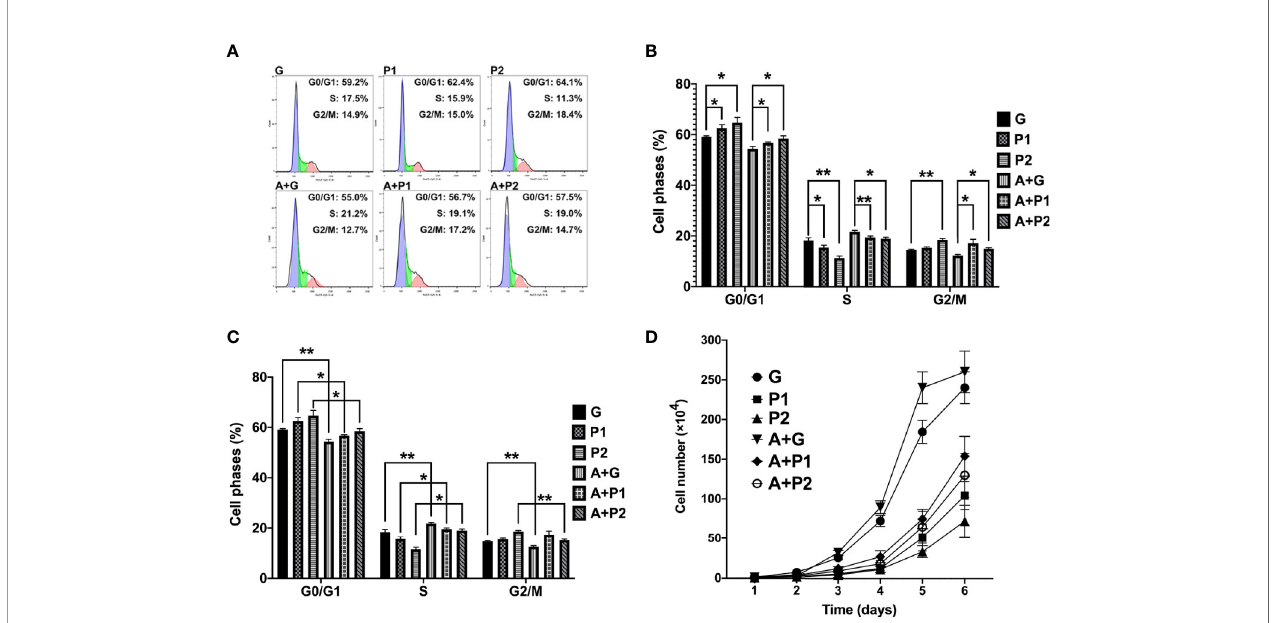
FIGURE 6 | It was revealed that propofol suppressed proliferation and cell cycle progression of glioma cells. (A – C) Cell cycle analysis of C6 glioma cells transduced with propofol or (R, S)-AMPA and analyzed by fl ow cytometry. (D) For the cell proliferation assay, 6 wells of cells from each group were randomly selected, digested and counted every 24 h for 6 days. Data are presented as the mean ± SD (n=6/group). *P < 0.05 and **P < 0.01. Groups: S, sham; G, glioma; P1 and P2, propofol 1.2, and 4.4 µg/ml -1 , respectively; A, (R, S)-